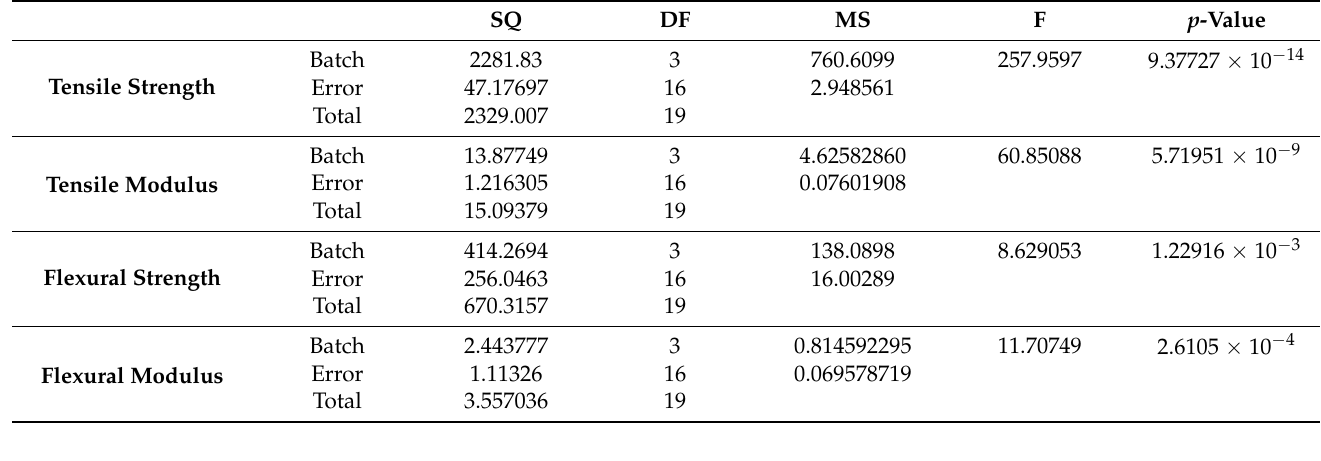
Table 1. Statistical results of the mechanical properties obtained from ANOVA.